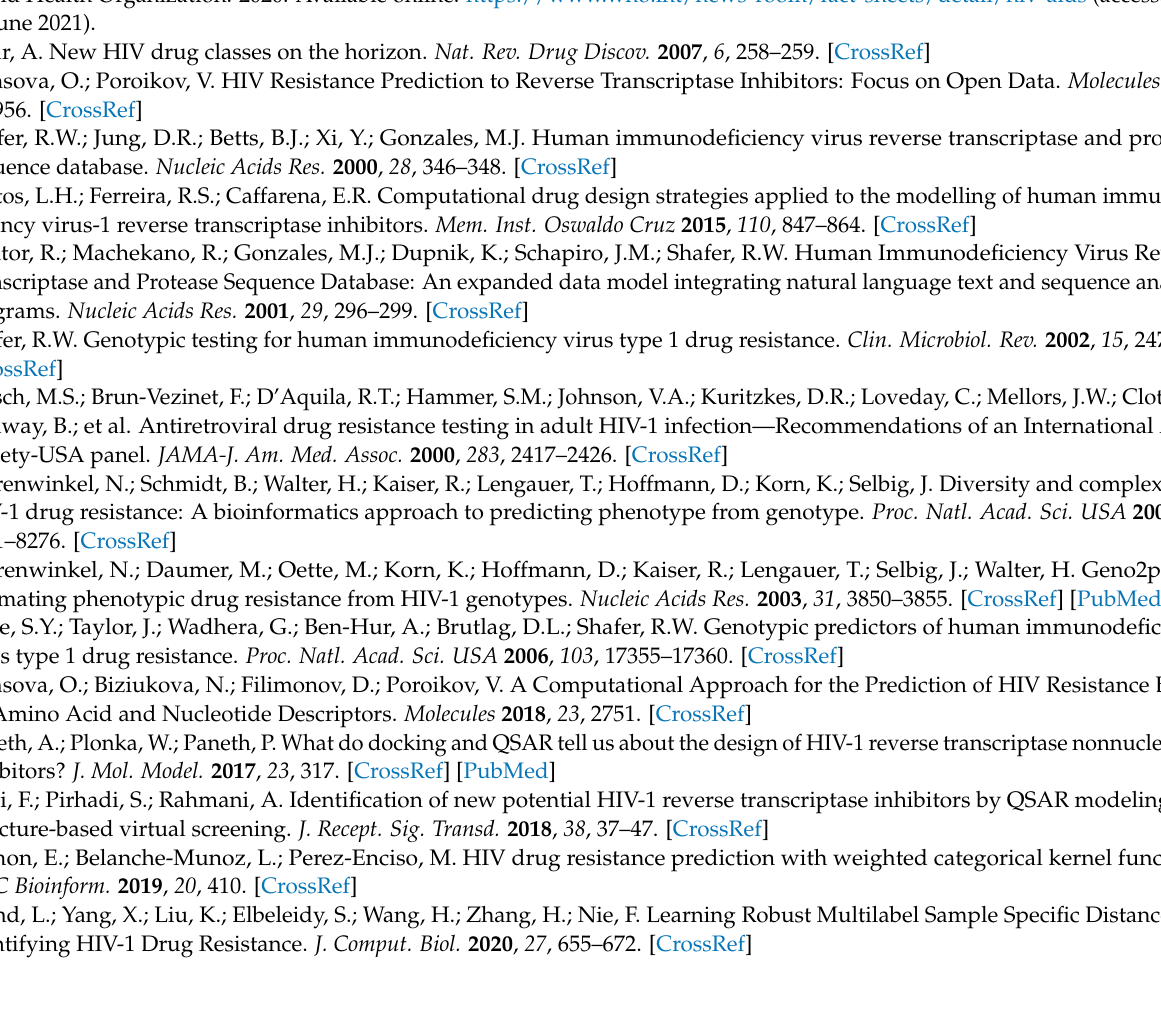
Table S5: Description of the 200-bit drug descriptors calculated by RDKit, Table S6: Hyper parameters of each tested machine learning models, Table S7: The detailed version of installed packages, Table S8: The nearest distance between 47 mutation sites and ligand binding atoms, Table S9: The p -value of Mann-Whitney test on the probability value for each class in 10-fold cross validation, Table S10: Model performance of the 10 times independent test, Table S11: List of top 40 ranked features, Table S12: SD(s j ) values on 10 important sites and 37 mutation sites, Table S13: The t -test result between SD(s j ) values on top 10 important sites and SD(s j ) on 37 other mutation sites, Table S14: Binding ability between each drug and mutated protein variants for each detected mutation